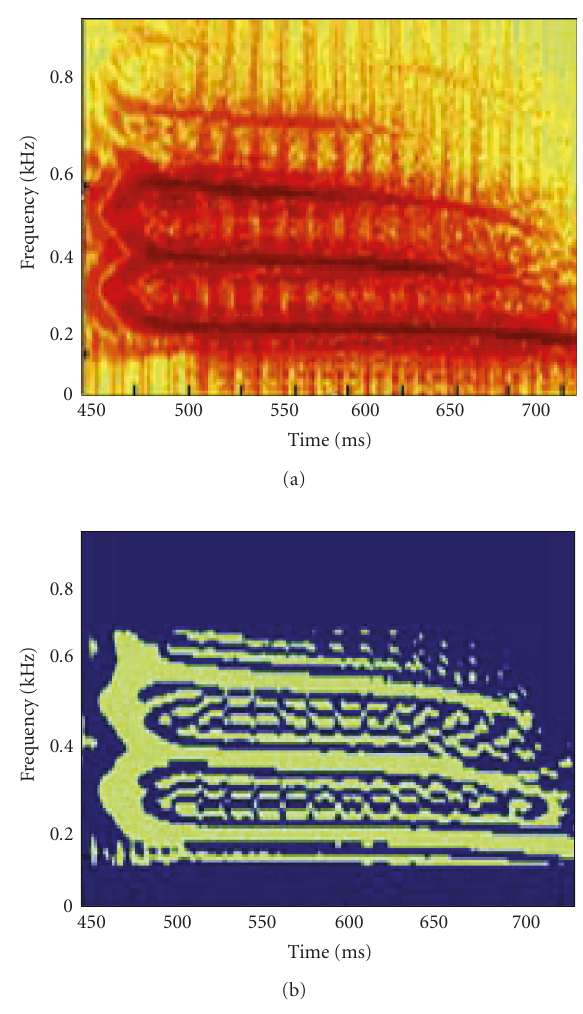
Figure 2: (a) Region D of analyzed speech signal, (b) support